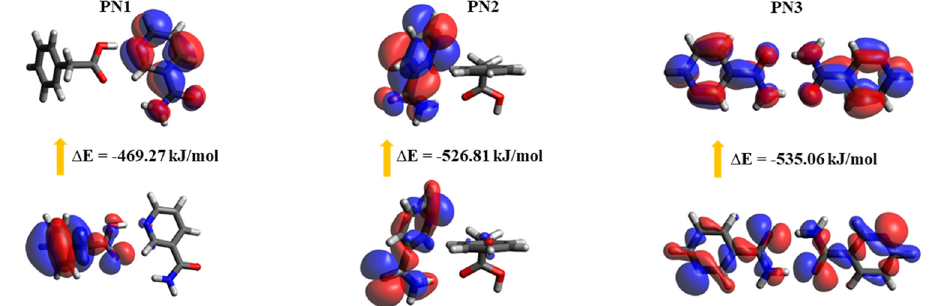
Figure 2: HOMO and LUMO view of existing PYCNIC conformation.